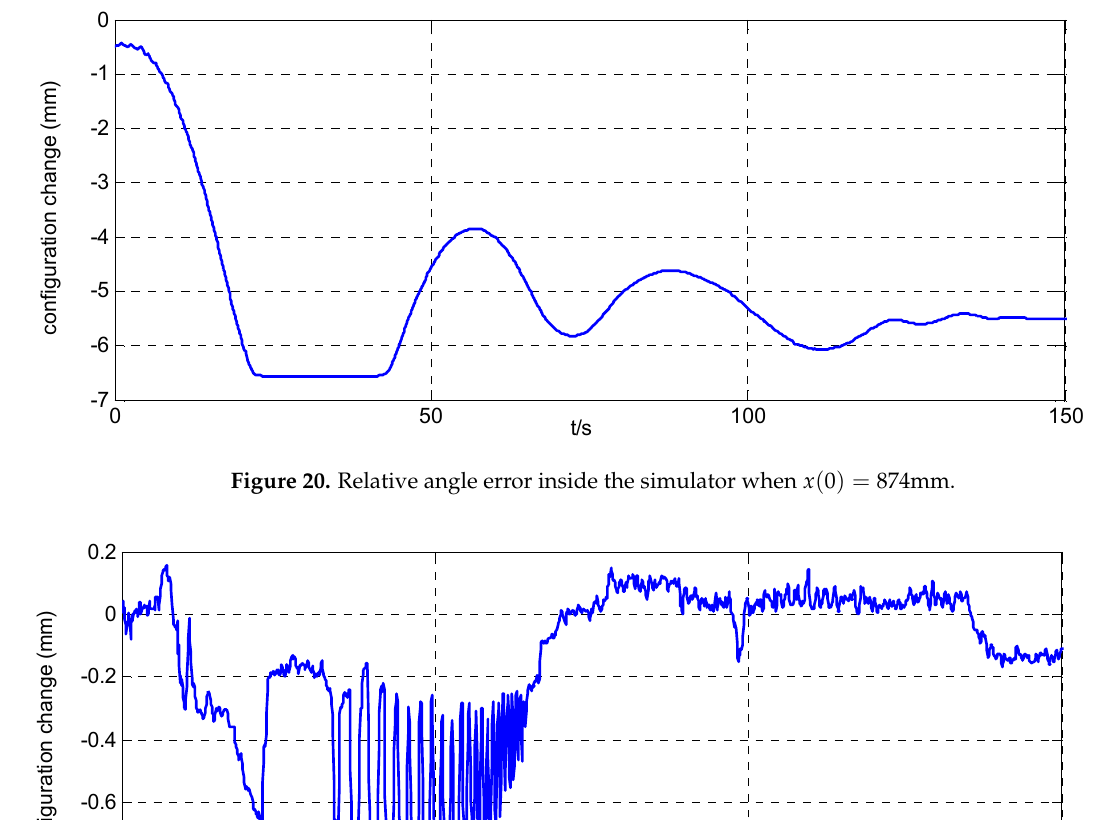
Figure 19. Velocity along the x-axis of the simulator when